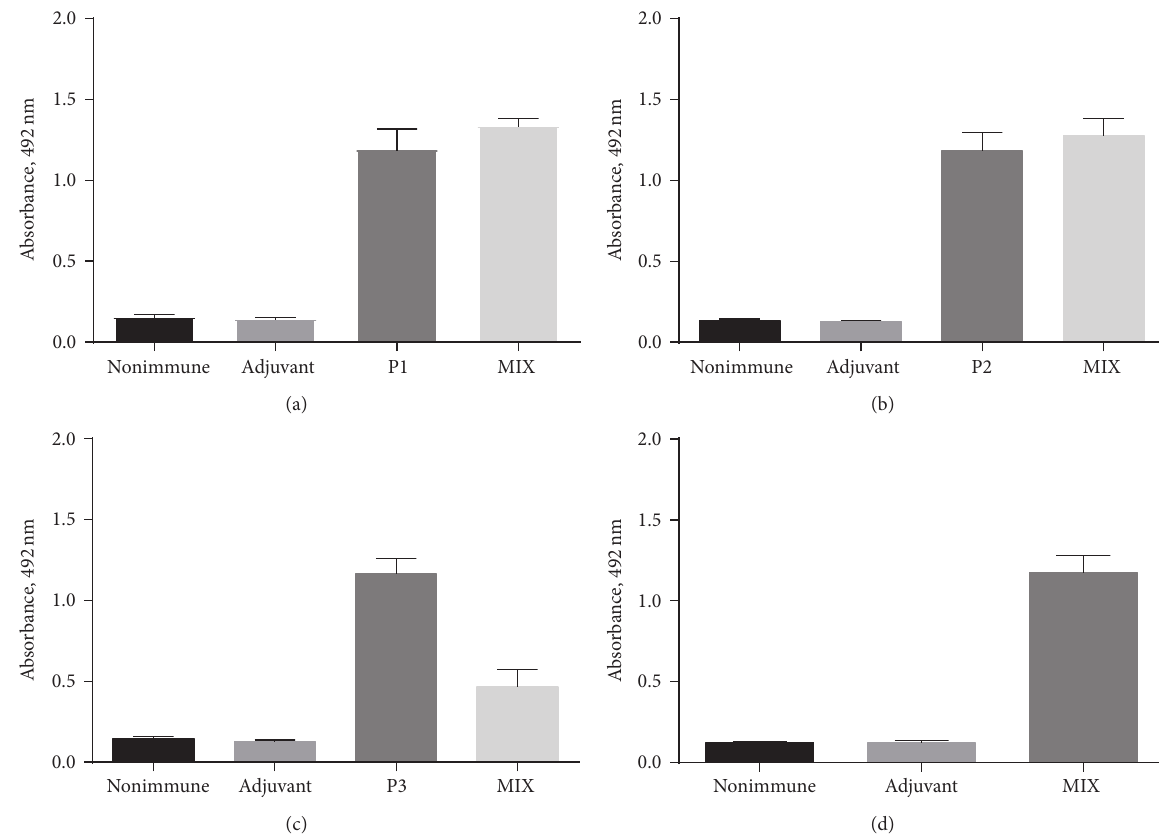
Figure 1: Reactivity of peptides with sera from immunized hamsters by ELISA. P1 peptide (a), P2 peptide (b), P3 peptide (c), and MIX of P1, P2, and P3 (d) were tested with anti-peptide serum P1 (P1), anti-peptide serum P2 (P2), anti-peptide serum P3 (P3), anti-peptide serum MIX (MIX), nonimmune serum, and serum against Freund’s adjuvant. ELISA plates were coated with peptide (2 𝜇 g/mL) and incubated with hamster serum diluted at 1: 50 (pool of sera with ten animals in each group). The detection reaction was conducted with anti-hamster IgG (whole molecule) peroxidase antibody (200